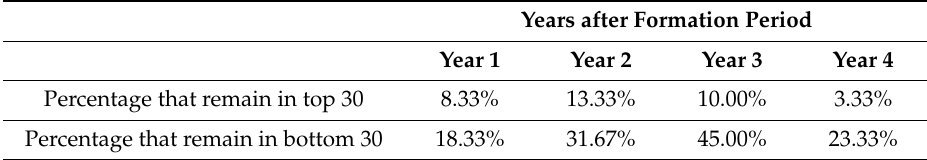
Table 5. Persistence in the extreme 60 Japanese mutual funds, according to each fund’s alpha over rolling one-year formation periods